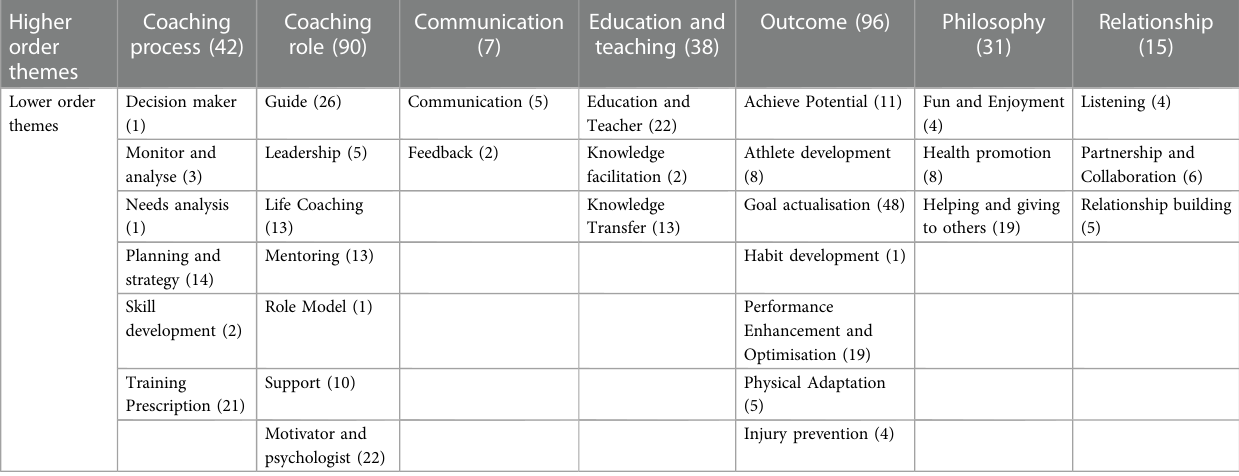
TABLE 7 The role of endurance coaches (with occurrences presented in